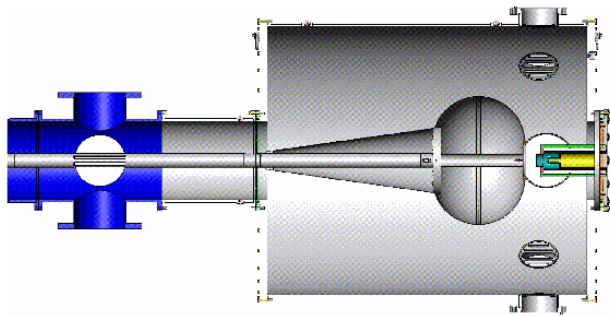
FIG. 14. (Color) Diagram of the conical field shaper attached to the cathode and terminating in the ‘‘knob.’’